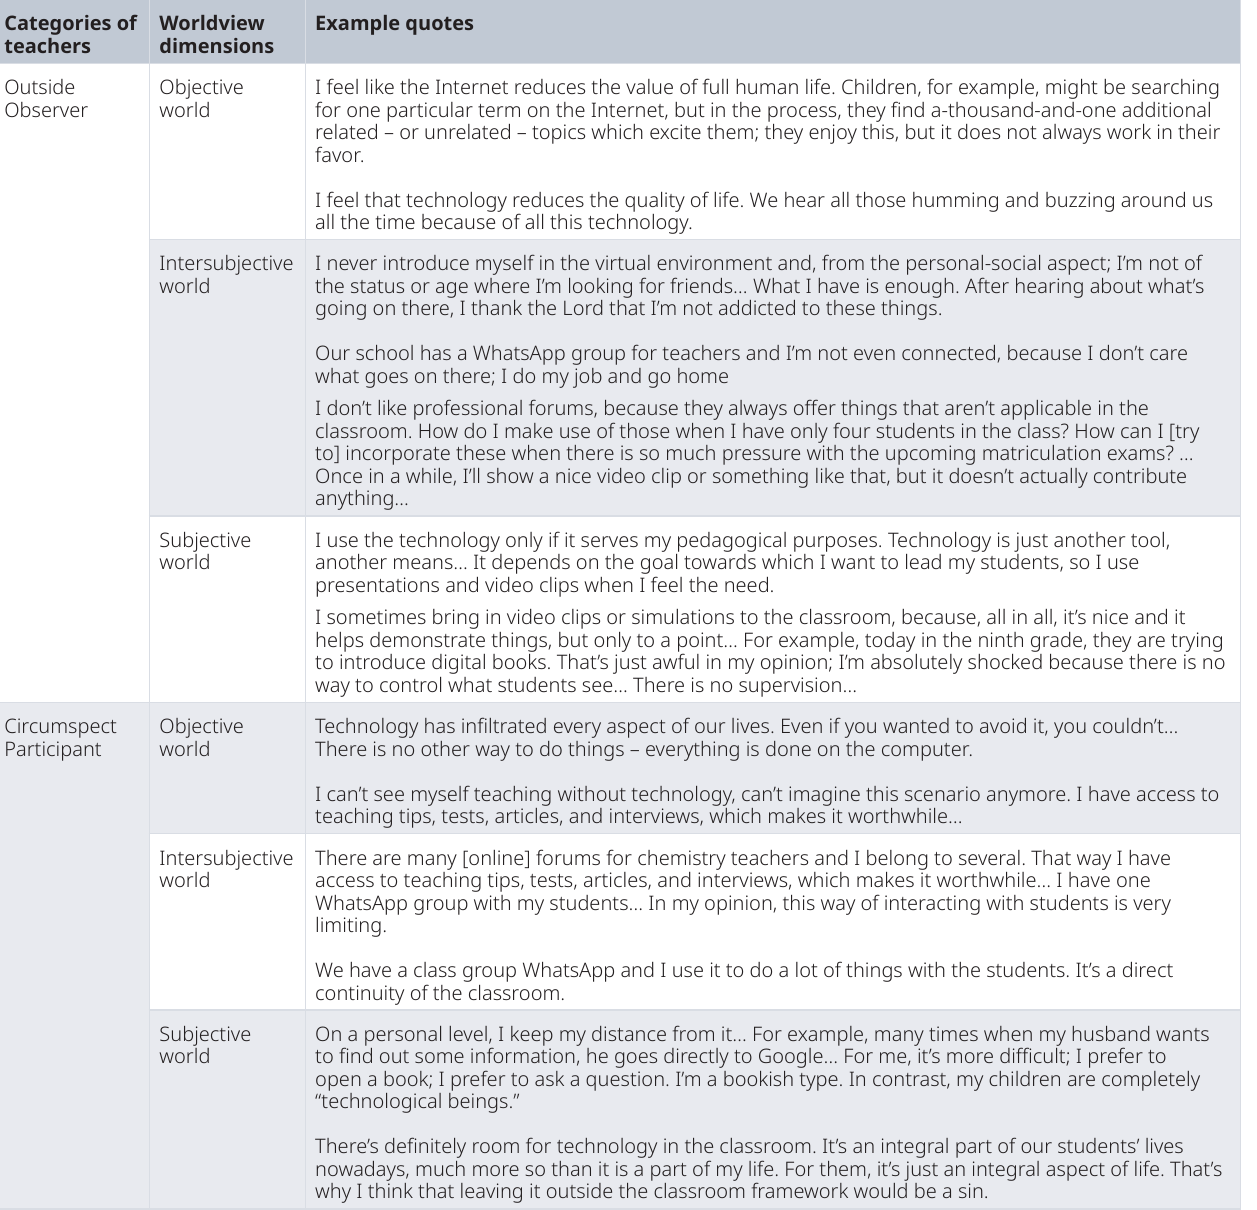
Table 1. Three categories of teachers and illustrative example quotes. Categories of